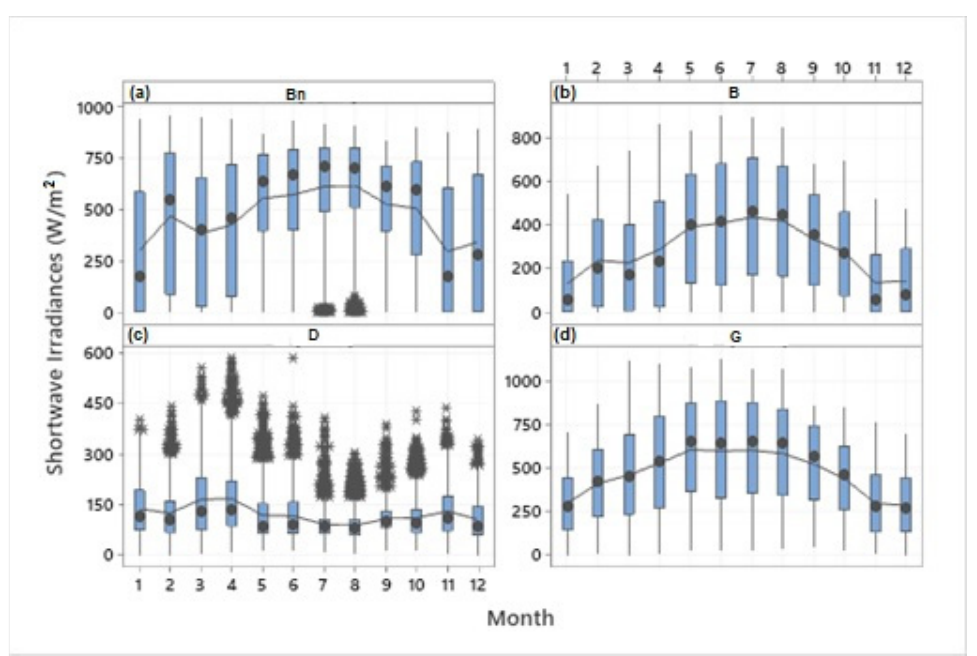
Figure 16. Isoline diagrams of monthly mean hourly: ( a ) direct normal; ( b ) direct horizontal; ( c ) diffuse; and ( d ) global irradiance values (W/m 2 ).